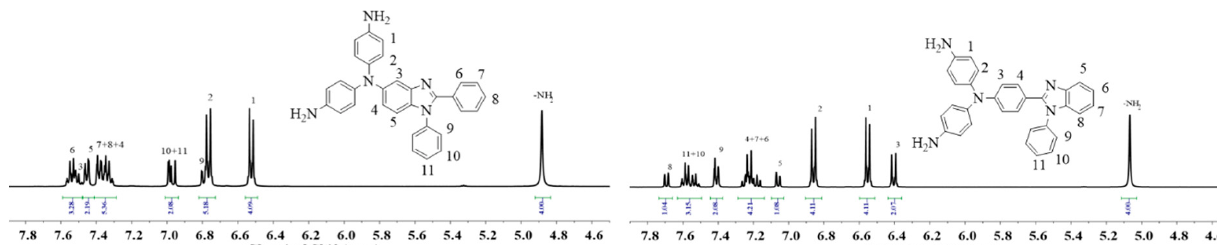
Figure 2. 1 H-NMR spectra of TPA-BIA-NH 2 and TPA-BIB-NH 2.